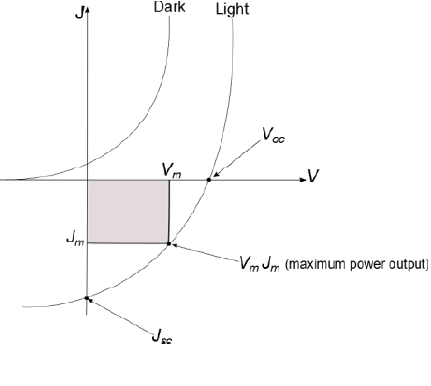
Figure 2. J–V curve for photovoltaic cells with and without